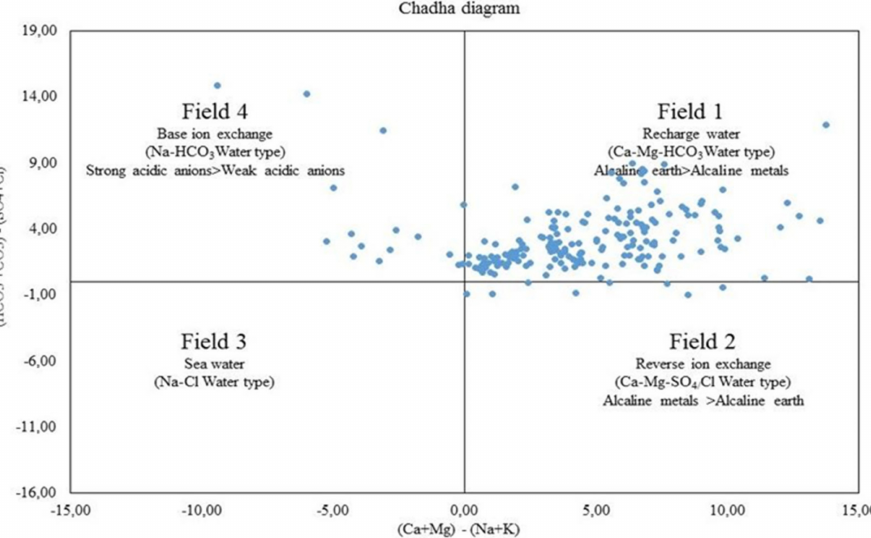
Figure 19. Geochemical classification based on Chadha’s diagram.